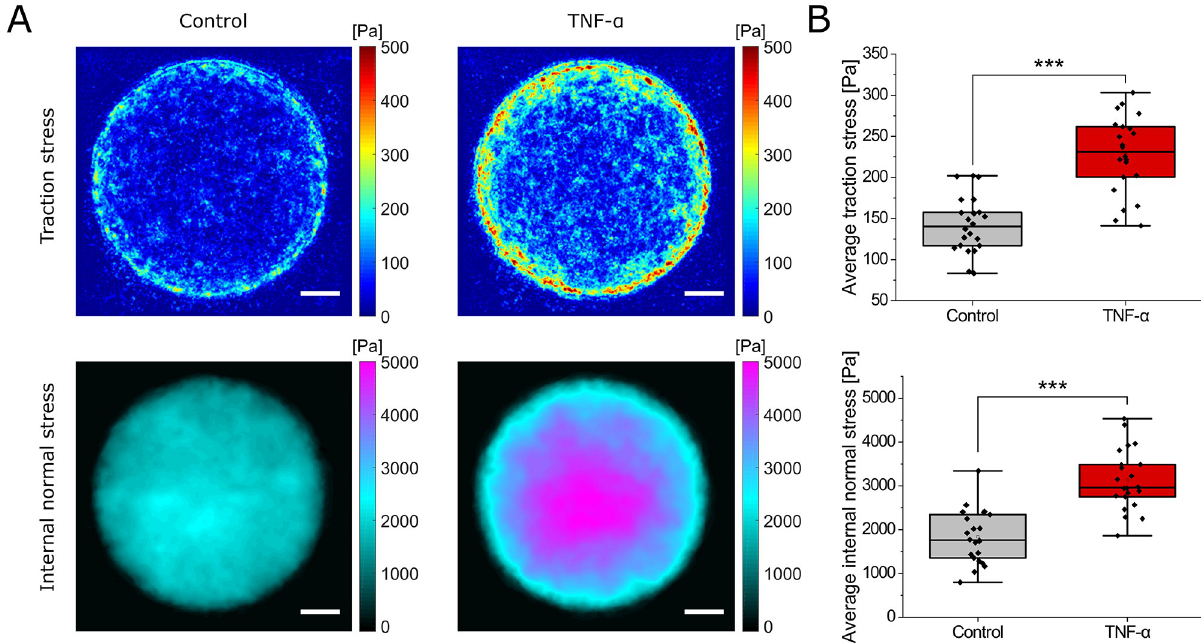
Fig 2. Increase of both traction and internal normal stress upon exposing HUVECs to 20 ng/ml TNF- α for 1 h. A : Spatially overlayed and averaged color-coded maps of derived substrate traction and internal normal stress of multiple monolayer patches prior to (Control) and upon application of TNF- α . Since the spatial averaging reduces the signal-to-noise ratio, a force level threshold was applied prior to the averaging for better visualization. Scale bars, 50 μ m. B : Average traction stress (top) as well as internal normal stress (bottom) increased significantly after 1 h of TNF- α treatment. Data for A and B is based on n = 22 monolayer islands from N = 3 independent experiments; ��� , p <